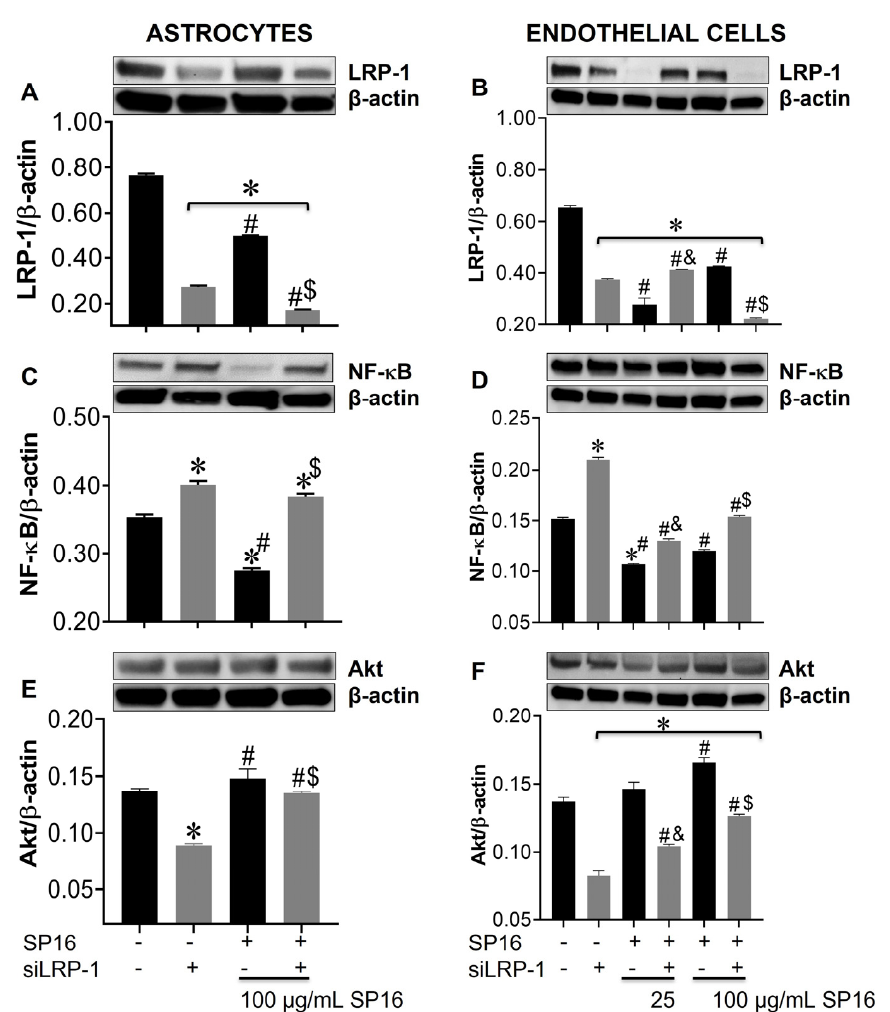
Figure 7. Silencing the LRP-1 gene leads to increased expression levels of NF- κ B and decreased levels of Akt in astrocytes and endothelial cells. Cell lysates from astrocytes ( A , C , E ) and endothelial cells ( B , D , F ) were collected after 12 h and LRP-1 ( A , B ), NF- κ B ( C , D ), and Akt ( E , F ) expression were measured by immunoblotting. Results are reported as the mean ± SEM of three independent experiments. Data were analyzed using one or two-way ANOVA analysis followed by Dunnett multiple comparisons. A value of p < 0.05 was considered significant. * vs. SP16/-siLRP-1; & vs. 25 μ g/mL SP16; $ vs. 100 μ g/mL SP16/-siLRP-1; # vs. SP16.